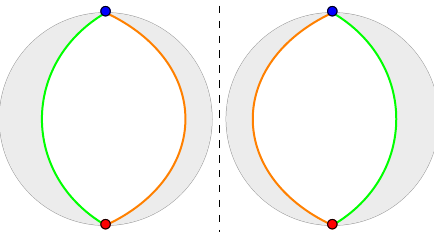
Figure 8. Two wedges left over after modding out the translational symmetry. The Z 2 symmetry is the reflection with respect to the dashed vertical